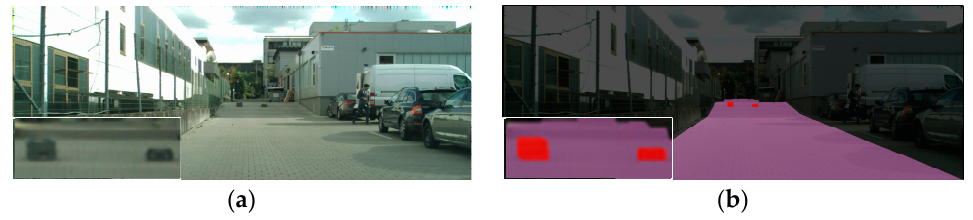
Figure 2. Classification of road scenes: ( a ) original image; ( b ) scene classification.